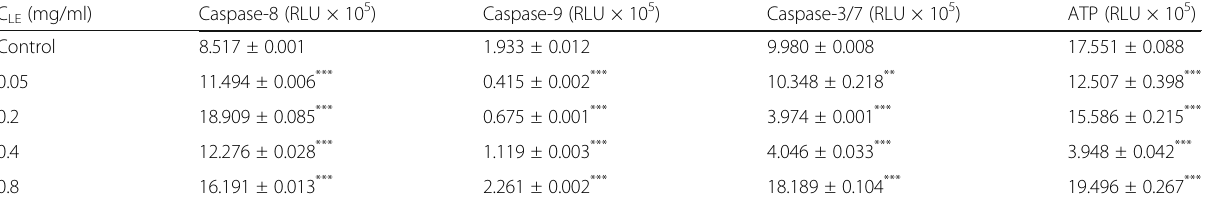
Table 3 Modulation of caspase ( − 8, − 9, − 3/7) activities and ATP levels in 24 h C LE treated THP-1 cells C LE (mg/ml)